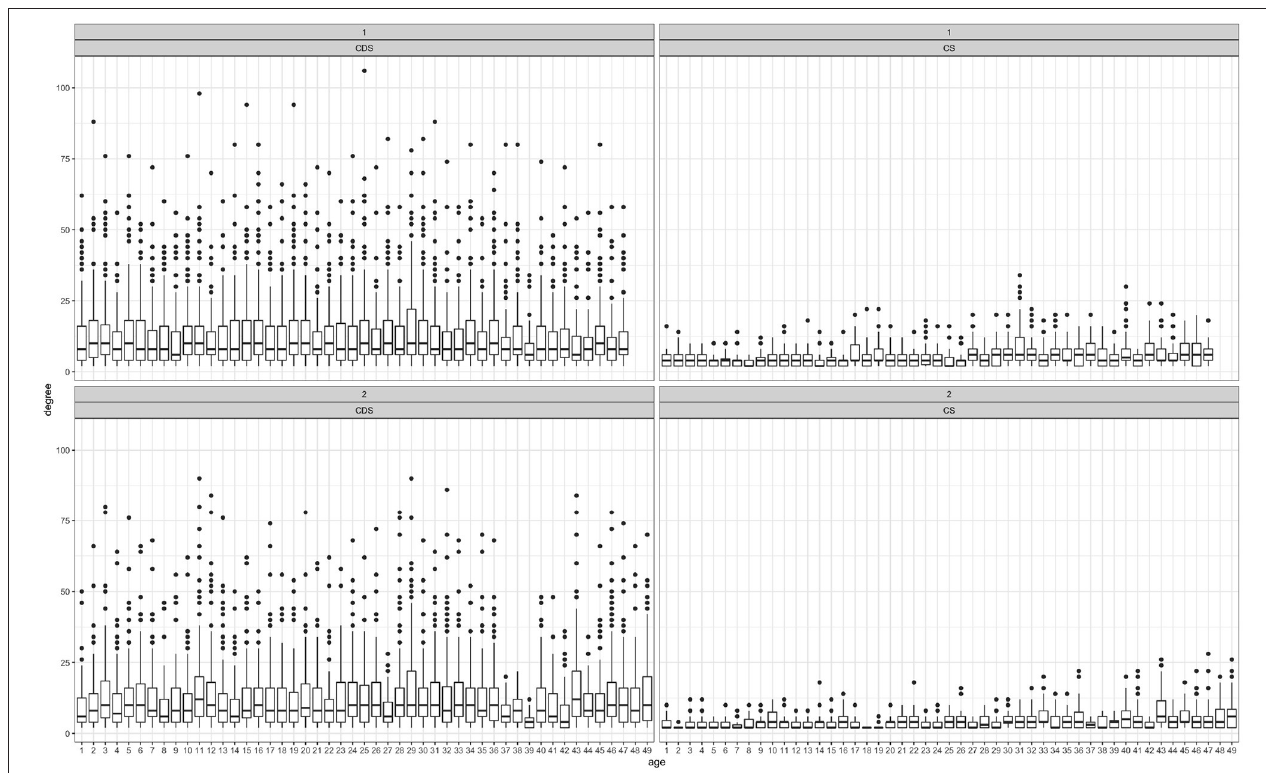
FIGURE 4 | Node degree distribution by session: CS (right panels) and CDS (left panels), child 1 (top panels) and child 2 (bottom